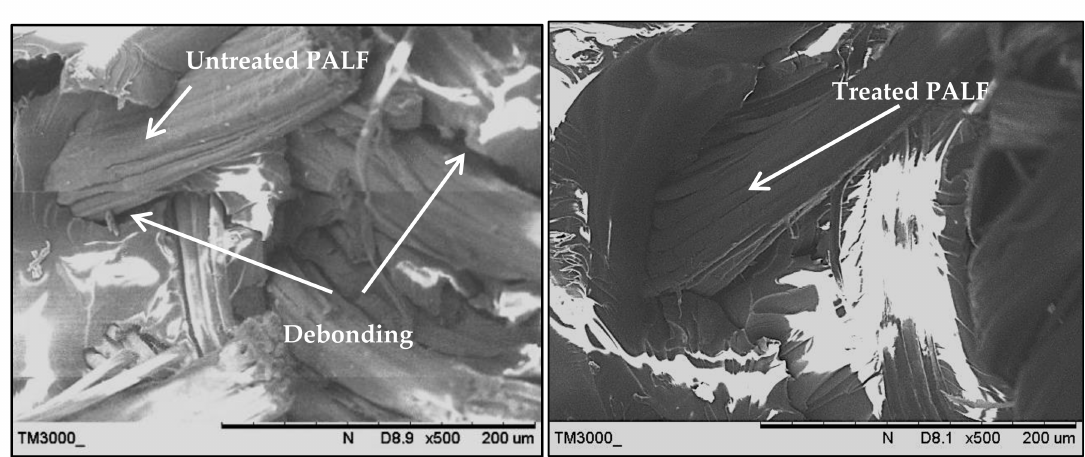
Figure 8. Scanning electron microscopy images of the untreated PALF laminate (PPPP-untreated) and the treated PALF laminate (PPPP-treated) with ply orientation [ ± 45 ◦ ] n .